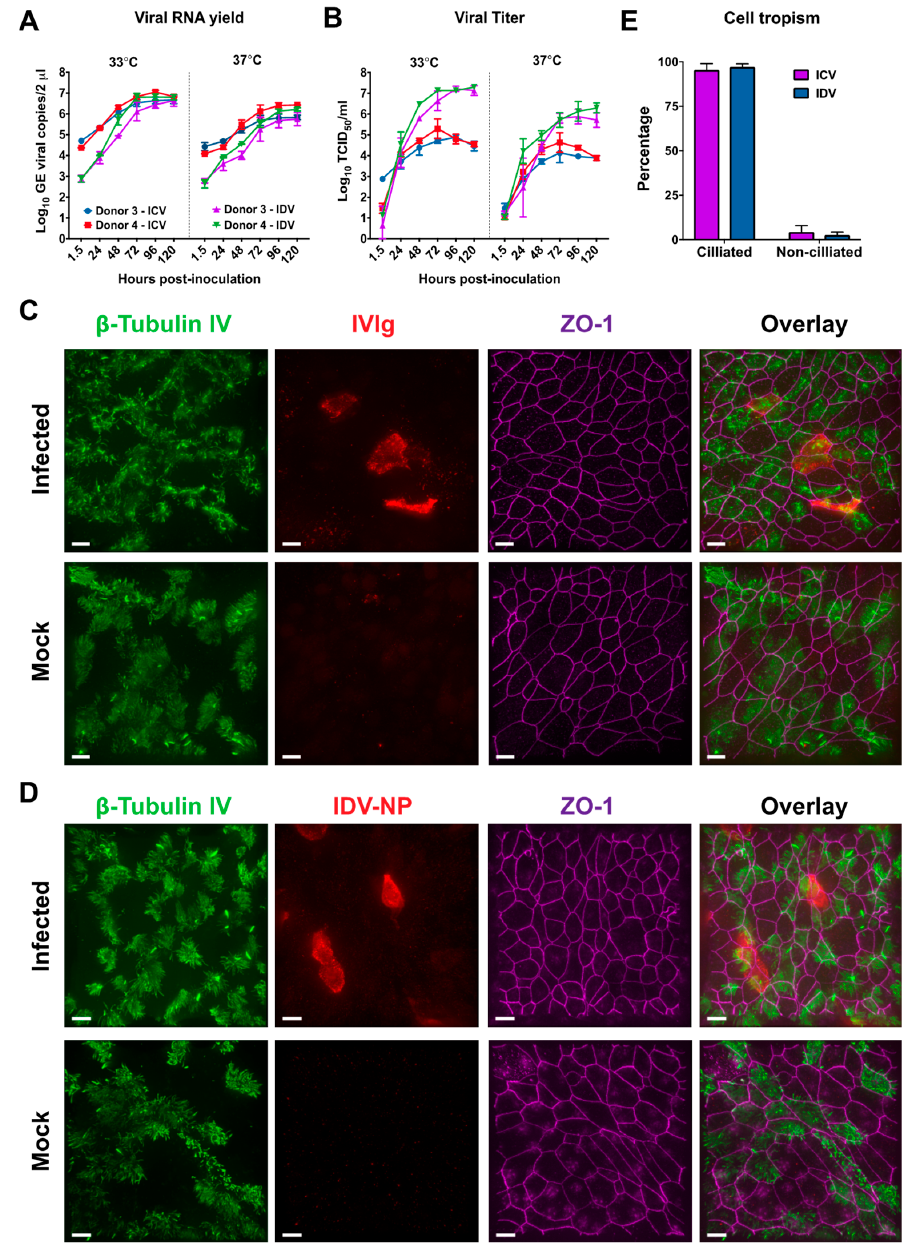
Figure 3. Comparison of Influenza C virus (ICV) and IDV infection in well-differentiated hAEC cultures. Human airway epithelial cell cultures were inoculated with 10,000 TCID 50 of ICV or IDV and incubated at 33 °C and 37 °C. The monitored viral RNA yield is given as genomic equivalents (GE) per 2 µL of isolated RNA (y-axis) at indicated hours post-inoculation (x-axis) for ICV and IDV ( A ). The viral titers of the corresponding apical washes are given as TCID 50 /mL at indicated hours post-infection (x-axis) ( B ). The results are displayed as means and SD from duplicates from two independent donors. Formalin-fixed ICV and IDV infected well-differentiated hAEC cultures and their respective controls were immunostained with antibodies to visualize the cilia ( β -tubulin IV, green), tight junction borders (ZO-1, purple). Whereas virus-infected cells (red) were visualized with either a custom generated IDV NP-antibody or intravenous immunoglobulins (IVIg) for ICV ( C & D ). Magnification 60×, the scale bar represents 10 micrometers. The cell tropism of ICV (purple bars) and IDV (blue bars) was quantified by calculating the percentage of viral antigen-positive signal co-localization with either ciliated or non-ciliated cells ( E ). The mean percentage and SEM from ten random fields from three independent donors are